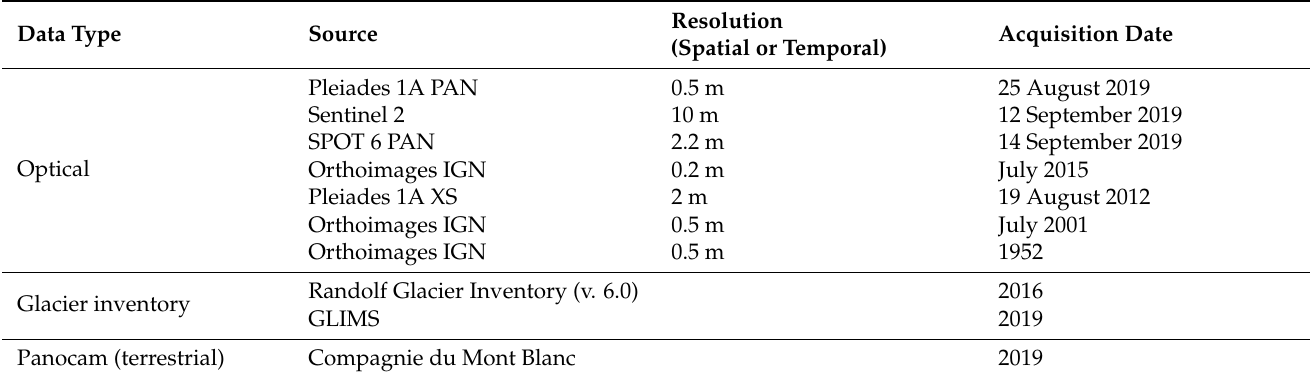
Table 1. Datasets used in the